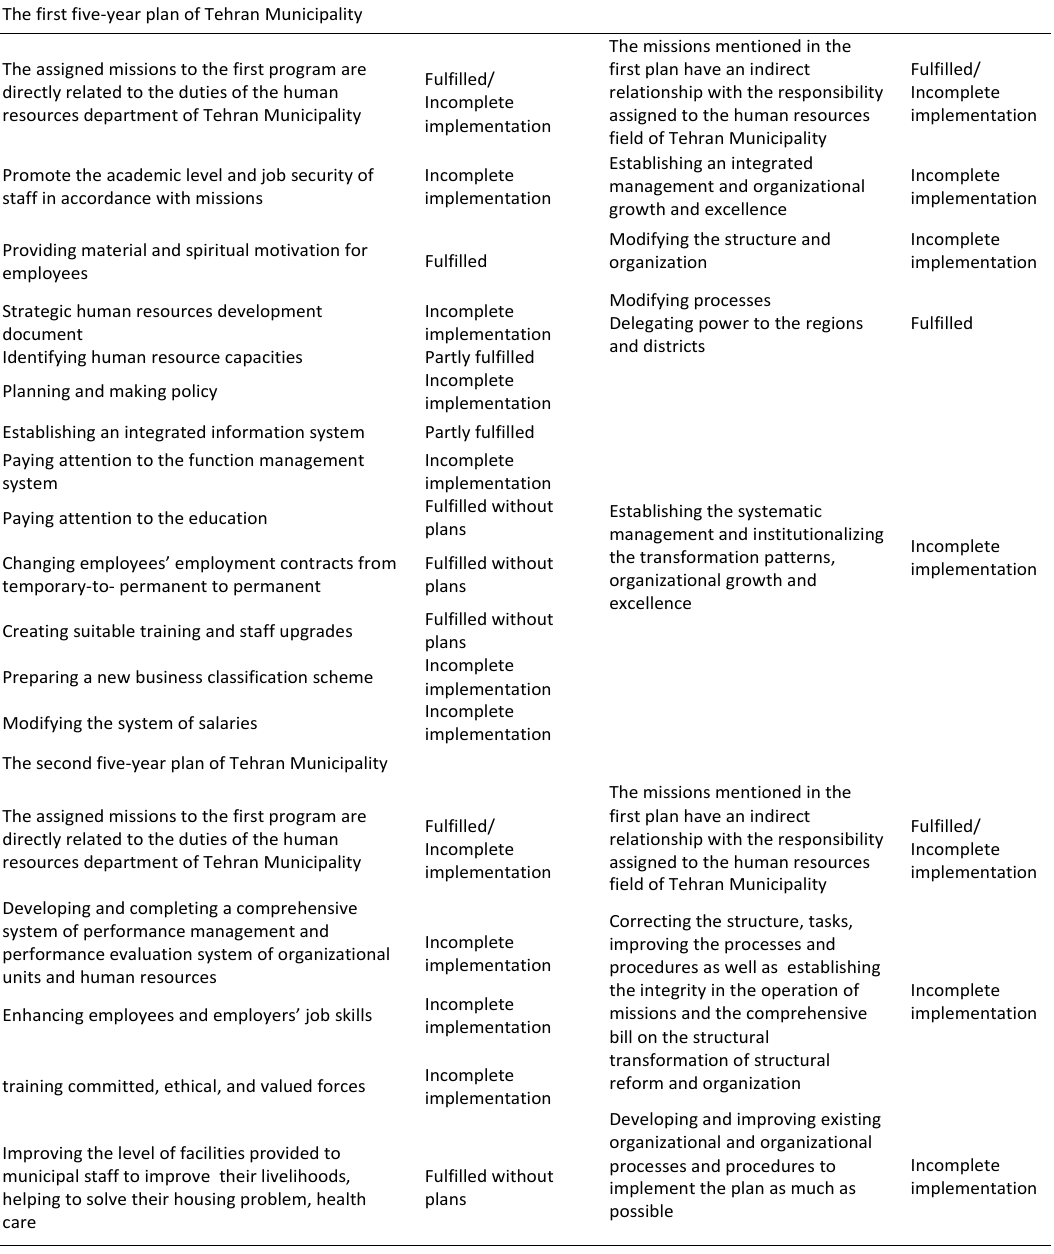
Table 6. Assessing the realization and anticipation of predicted plans